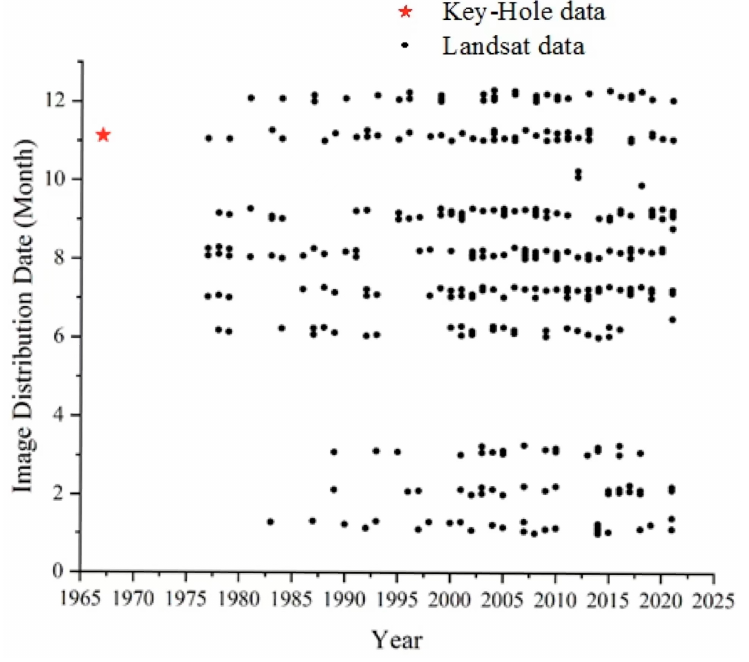
Figure 2. Remote sensing temporal data